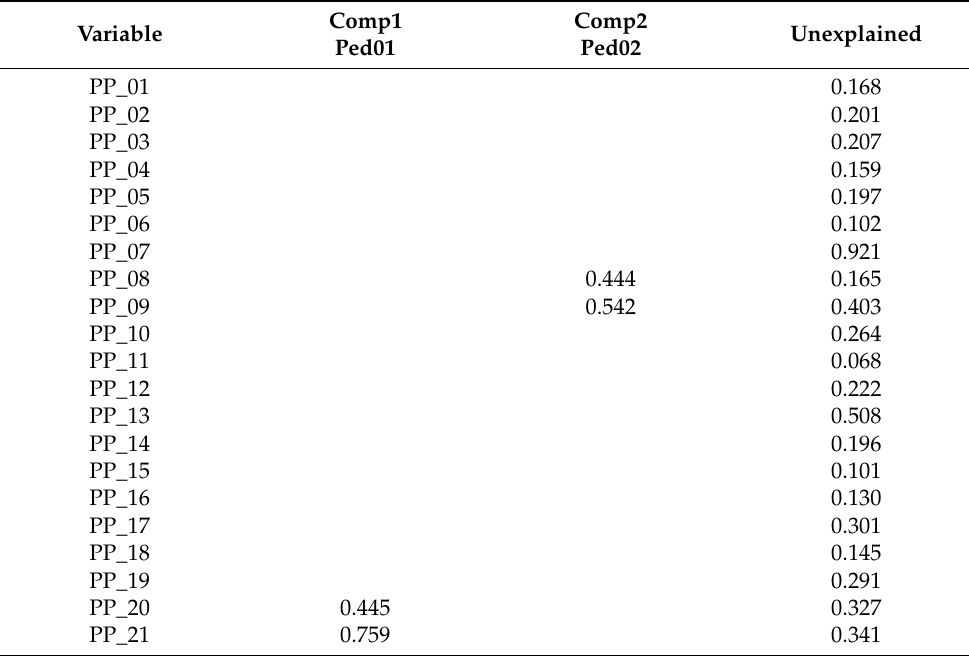
Table 21. Rotated component matrix—pedagogical